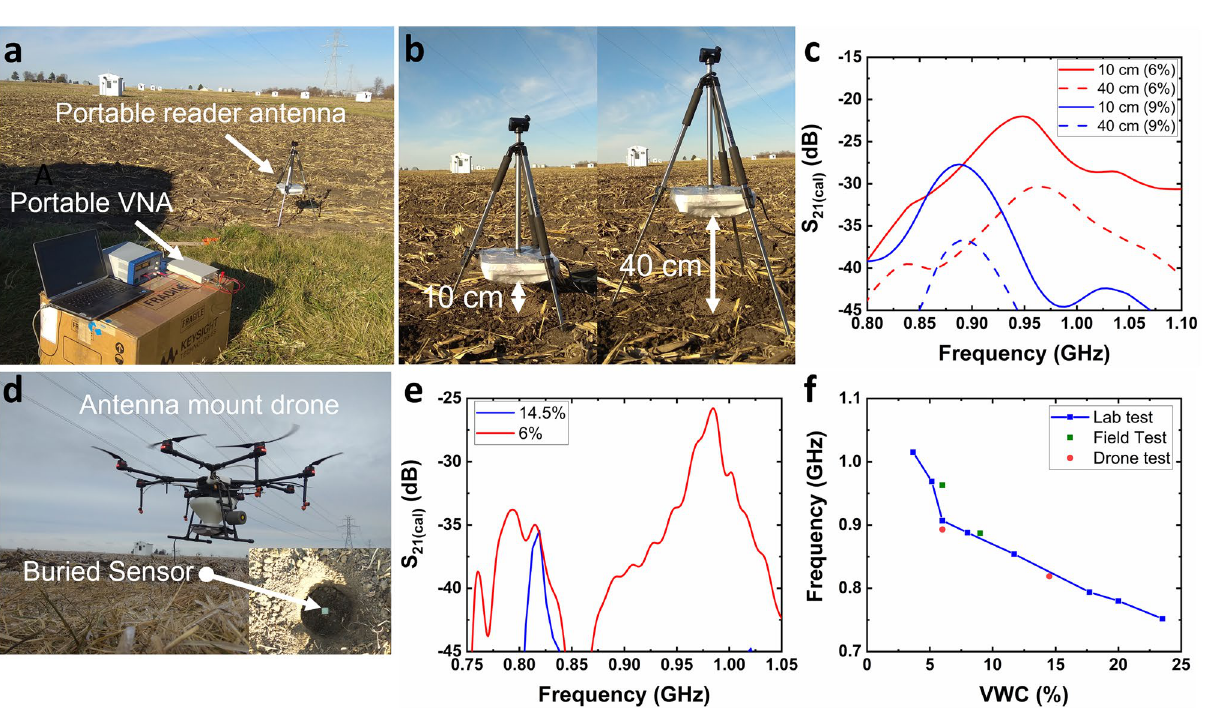
Figure 8. Experimental studies on DIRTS buried in the field when interrogated by a stationary reader and a drone-mounted reader ( a ) Photograph of the portable reader assembly in the field. ( b ) Photographs of the portable antenna loaded onto a stationary mount demonstrating RD = 10 cm, and RD = 40 cm. ( c ) Measured S 21 ( cal ) plotted as a function of frequency for a VWC of 6% and 9% when RD = 10 cm, and RD = 40 cm. ( d ) Photograph of the drone-mounted antenna hovering over a sensor tag. Inset shows the sensor tag placed at a depth of 5 cm before filling up the bored hole. ( e ) Measured S 21 ( cal ) plotted as a function of frequency as recorded by the drone from an elevation of ~ 40 cm for ground truth VWCs of 6% and 14.5%. ( f ) Comparison of the results obtained from the portable reader on the stationary mount and the drone with respect to the calibration curve obtained from the lab